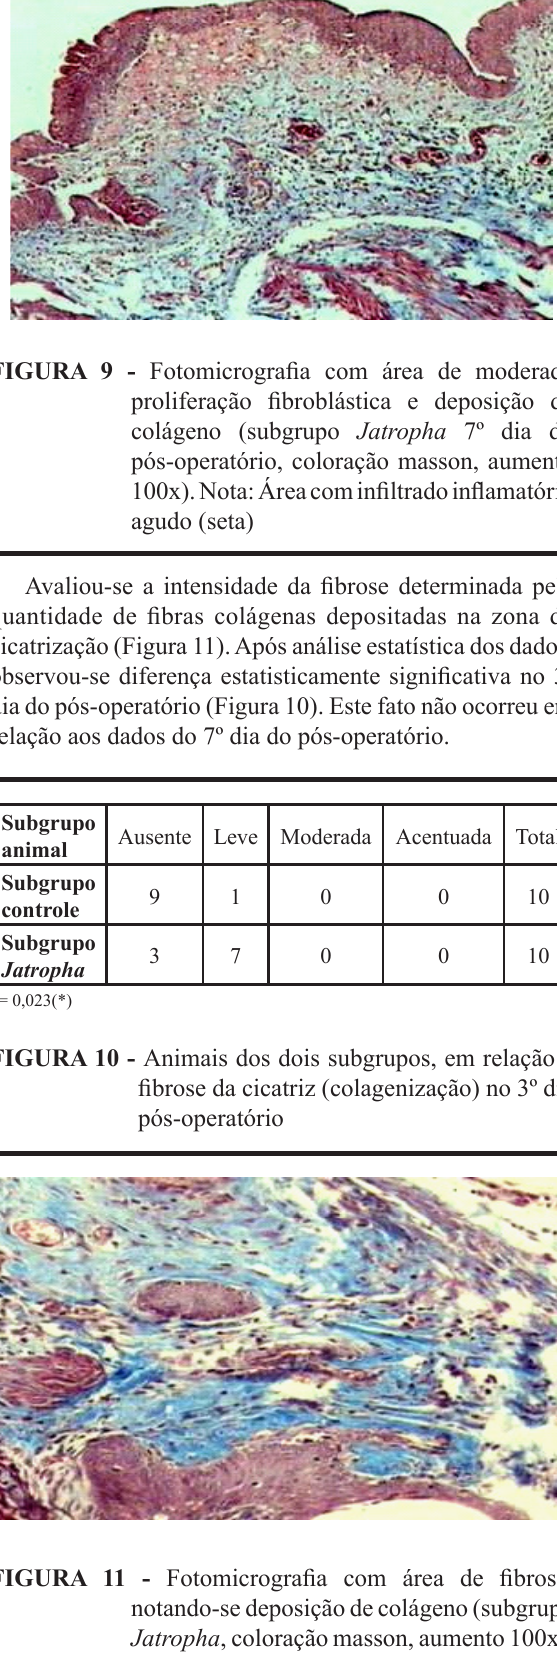
FIGURA 8 - Animais dos dois subgrupos segundo a proliferação fibroblástica no 7º dia do pós- operatório